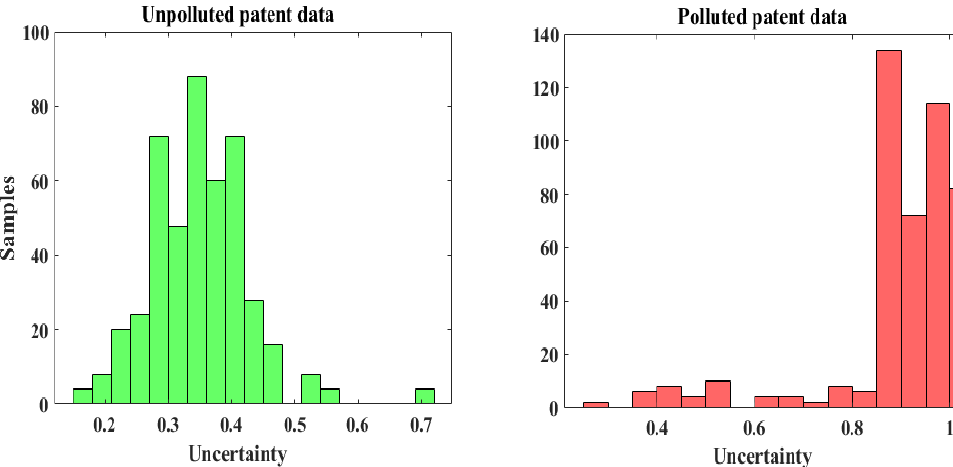
Figure 2. Uncertainty estimation on multi-view patent